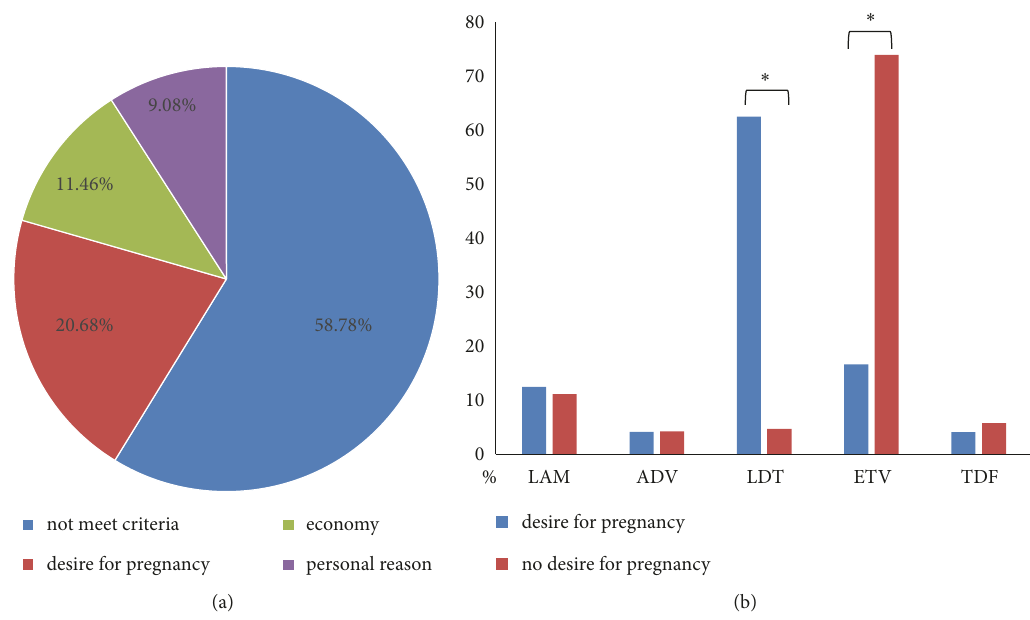
Figure 2: State of antiviral therapy in male chronic hepatitis B virus (HBV, CHB) patients. (a) Main reason why male HBV-positive participants did not receive antiviral treatment. (b) Analysis of nucleoside analog drug distribution in patients with or without desire for pregnancy.